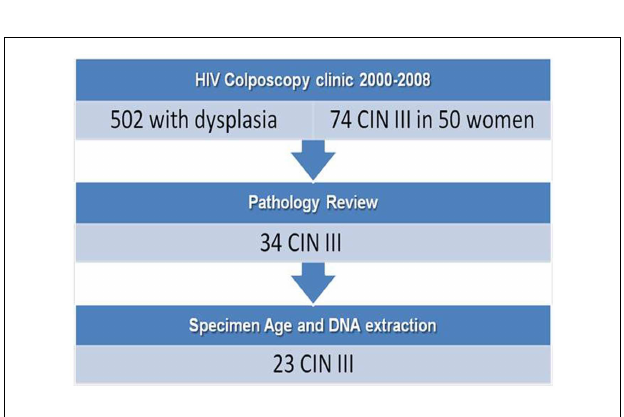
FIGURE 2 | Selection flowchart